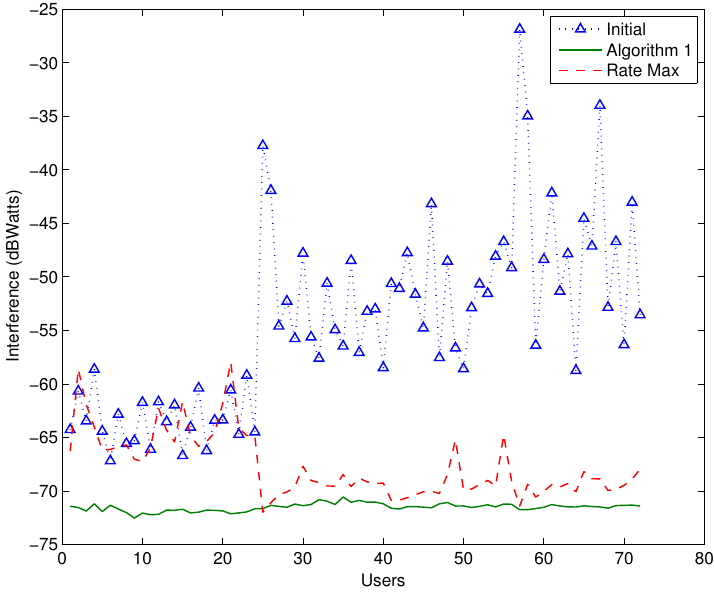
Figure 8. Comparison of interference (initial, Algorithm 1, Rate Max